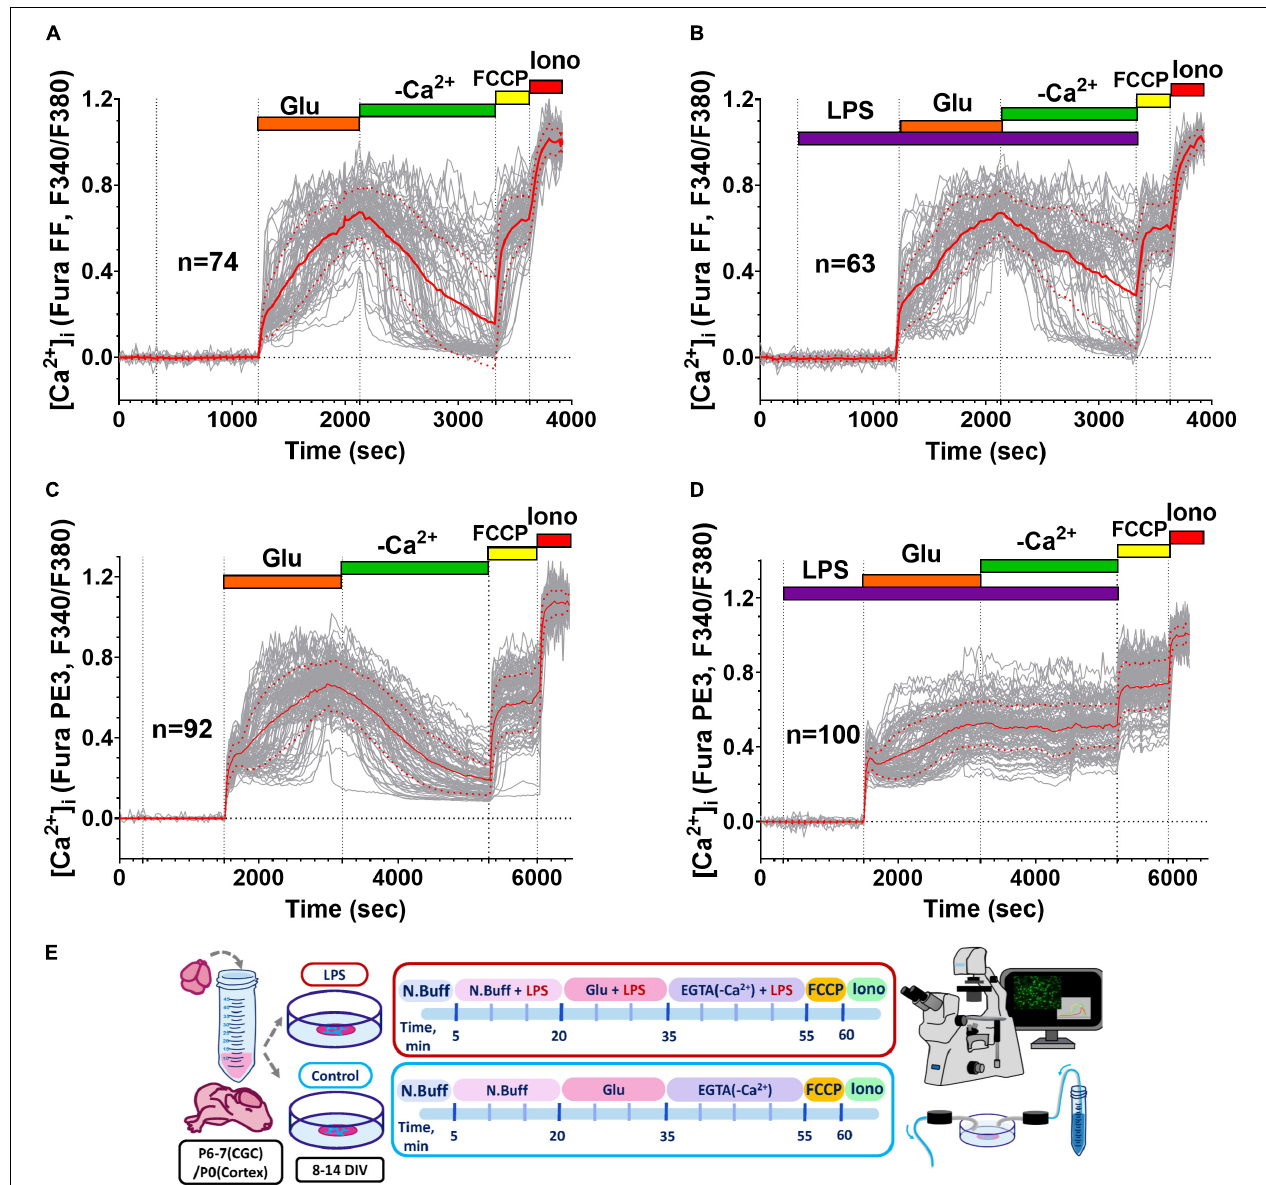
FIGURE 1 | Influence of E. coli lipopolysaccharide (LPS) on intracellular free Ca 2 + concentration ([Ca 2 + ] i ) changes induced by glutamate (Glu) in primary neuronal cultures. (A,C) Changes of [Ca 2 + ] i induced by Glu (100 µ M) alone and (B,D) in the presence of (LPS, 10 µ M), in cultured neurons of the rat cerebral cortex (A,B) and cerebellum (C,D) . The results of representative experiments are presented. Glu was co-applied with 10 µ M Gly in Mg 2 + -free buffer. [Ca 2 + ] i changes are presented as the ratio of fluorescence signals of the low- and high-affinity Ca 2 + indicators (Fura-FF and Fura-PE3, respectively) excited at 340 and 380 nm (F340/F380); emission was monitored at 525 ± 15 nm. Protonophore FCCP (1 µ M) was added in a calcium-free buffer at the end of the experiment to release into the cytosol Ca 2 + accumulated by mitochondria. The Ca 2 + -selective ionophore ionomycin (Iono, 2 µ M, 5 mM Ca 2 + ) was employed to calibrate the maximal Ca 2